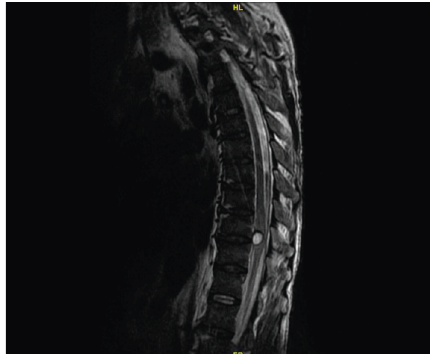
Figure 2: T2 MRI of the entire spine demonstrating a significant increase in the size of the previously noted lesion surrounded by a rim of a decreased gradient signal suggesting a hemorrhagic component and a likely picture of cord edema at T9-T10.